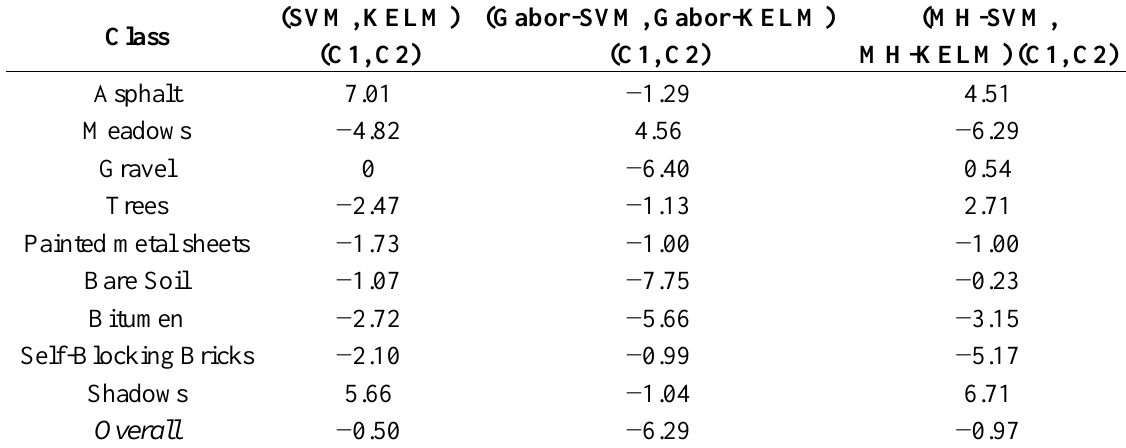
Table 7. McNemar’s test ( Z ) for the University of Pavia dataset (180 training and 7920 testing